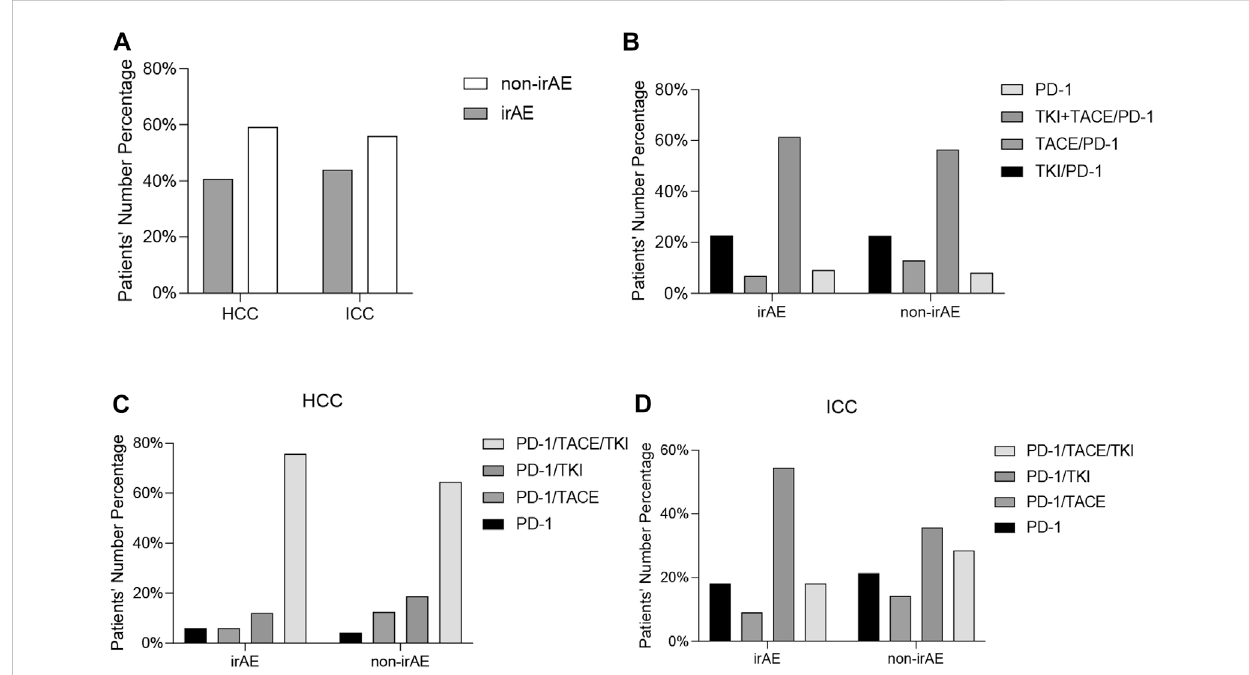
FIGURE 4 Comparison of the immune-related adverse events between HCC patients and ICC patients (A) . Comparison of immune-related adverse events between all patients (B) , HCC patients (C) , and ICC patients (D) receiving PD-1 inhibitors alone or in combination with TKI and TACE.